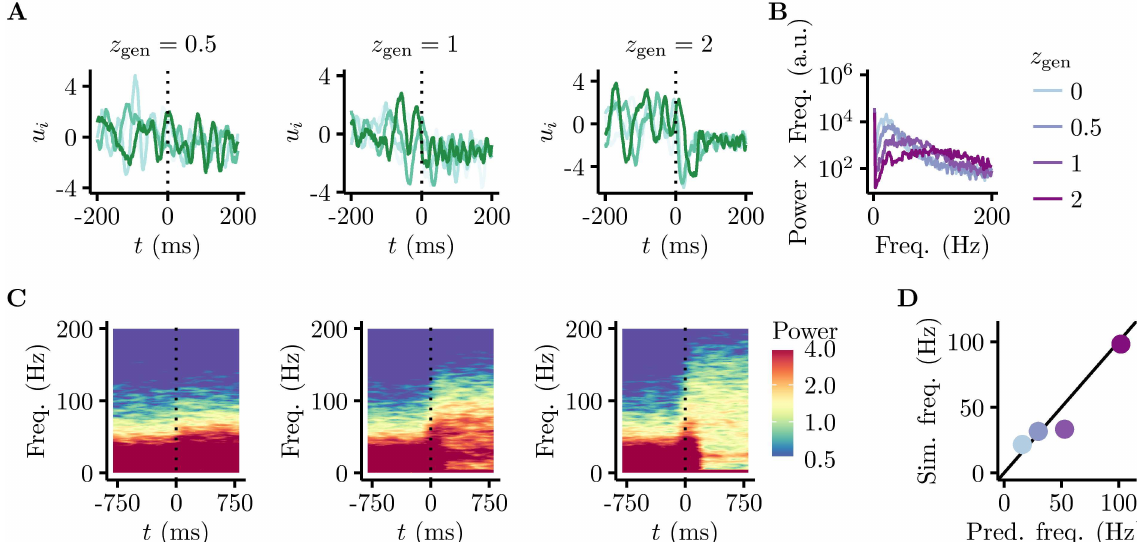
Fig 6. Oscillation frequency depends on stimulus contrast. A. The membranepotentialresponseof one neuronto stimulus onset across 4 trials (colouredcurves) shows that the variabilitydecreasesand the frequency increasesas stimulus contrast increases.The true contrast of the underlyingimage increasesleft to right ( z gen = 0.5, 1, and 2). B. Power spectrum of the LFP (average membranepotentials)at different contrasts (colouredlines), showingthat dominant oscillationfrequency increaseswith contrast. Note that we plot power × frequency on the y-axis, in order to accountfor the fact that noise from a “scale-free”process has 1/f frequencydependence[59]. C. Time-dependent spectrum (Gaussian window, width 100 ms) of the LFP (contrast levels as in A ). D. The simplifieddynamics (x-axis, Eq 8) accuratelypredictedthe dependence of oscillationfrequencieson contrast (colour code as in B) in the full network (y-axis).